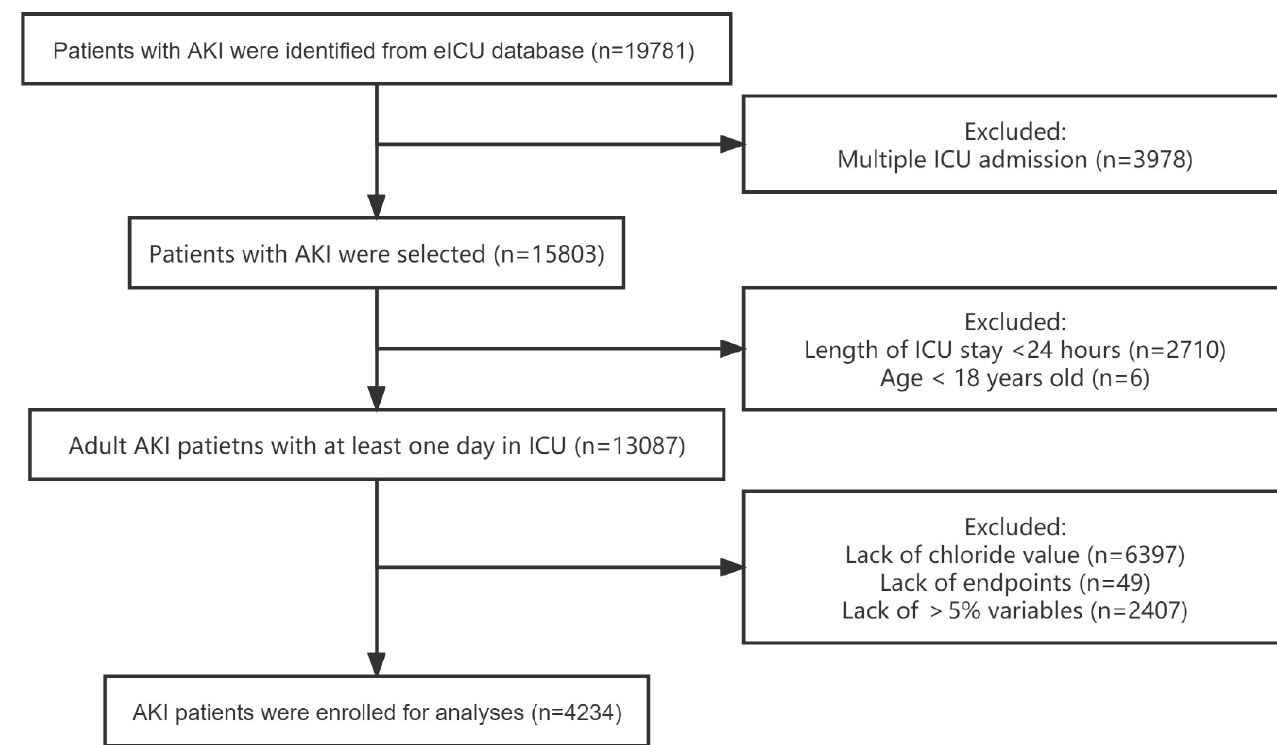
Fig 1. Flowchart of included patients. Abbreviations: AKI, acute kidney injury; ICU, intensive care unit.